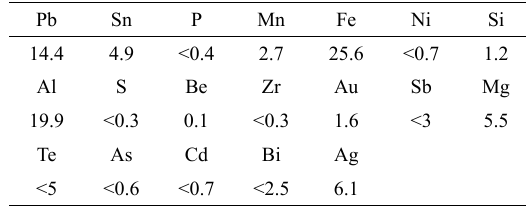
Table 2. Chemical composition of